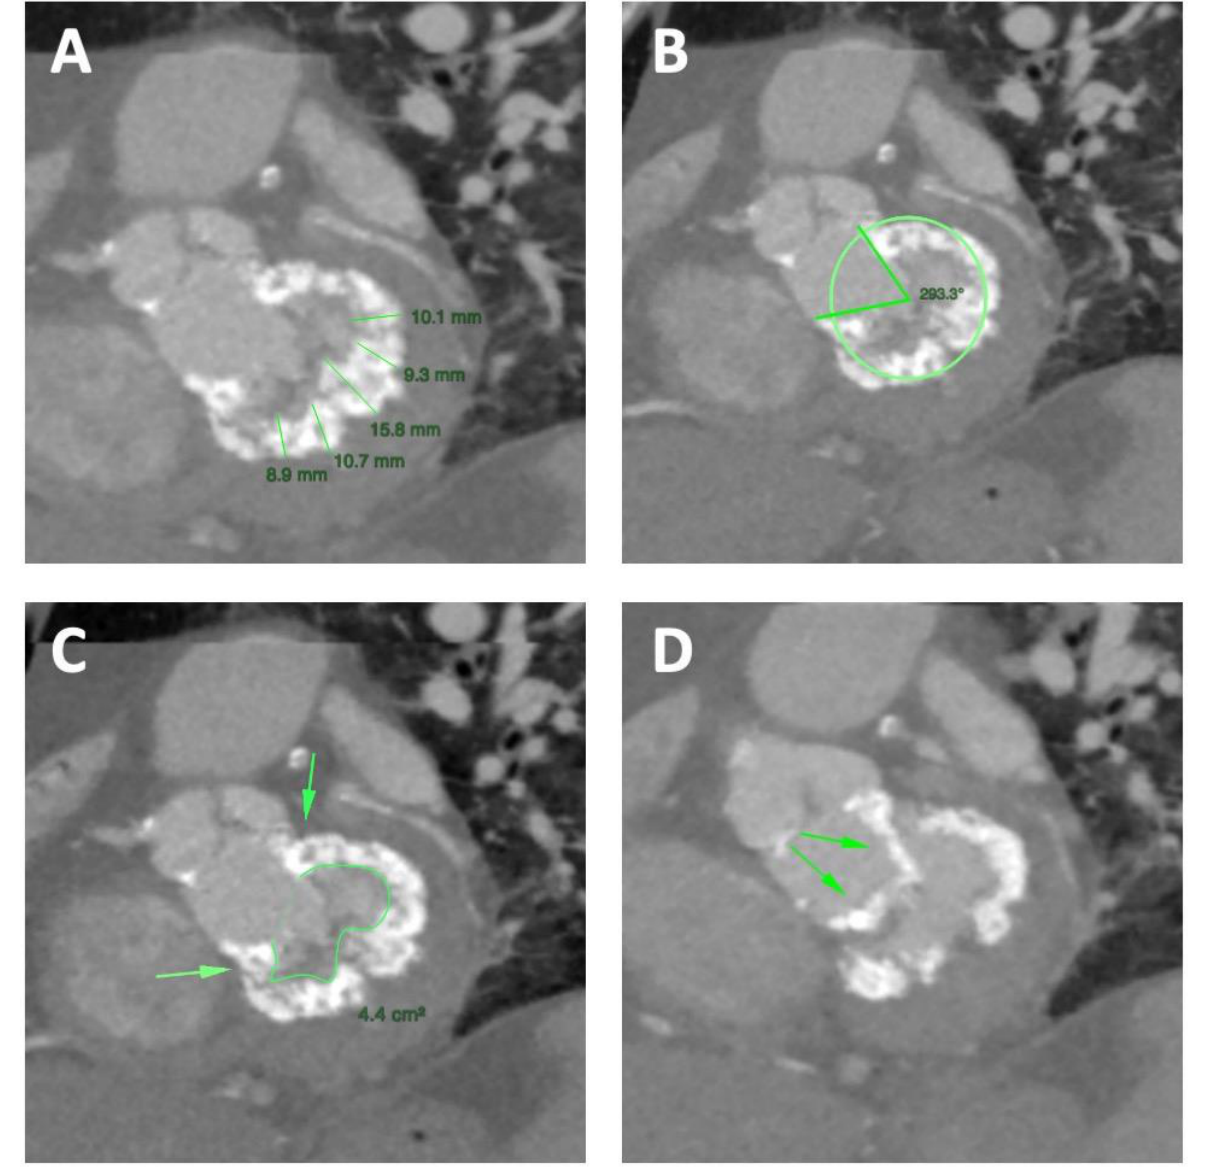
Figure 2. Cardiac computed tomography-based measurements of MAC using DICOM “OsiriX MD” viewer. ( A ) Calcium thickness measurement simulating a surgical short axis view. ( B ) Calcium distribution along the perimeter of the annulus. ( C ) Trigone involvement (arrows) and internal area of the annulus. ( D ) Leaflet involvement (arrows).